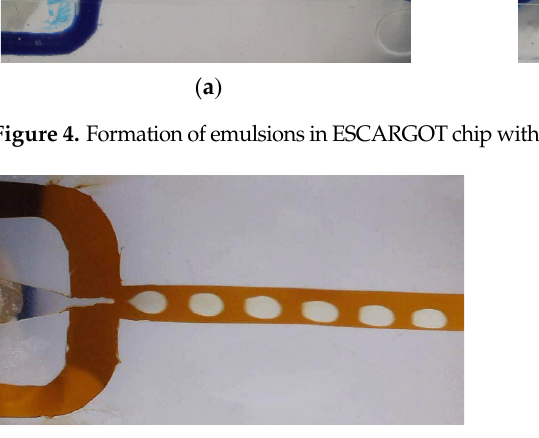
Figure 5. Dynamics of water droplets in MF in sandwich chip with glass walls (Figure